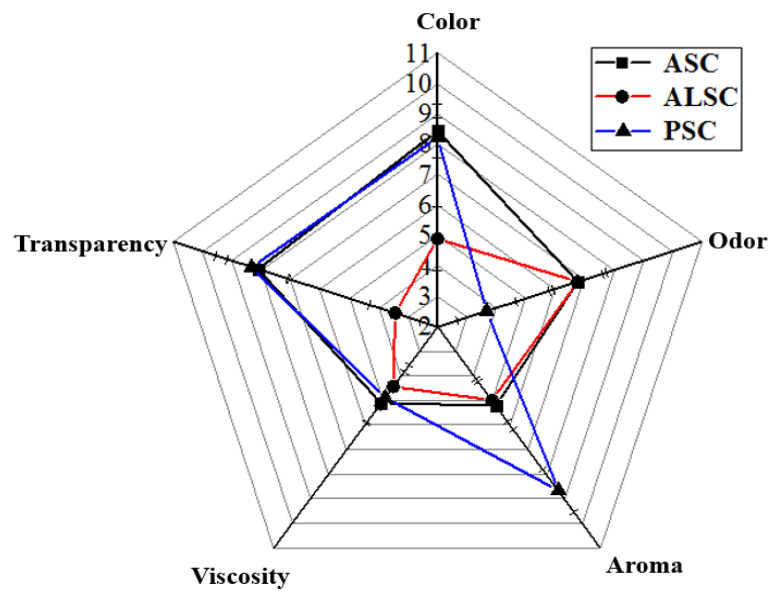
Figure 8. Radar chart of sensory analysis of ASC, ALSC, and PSC.